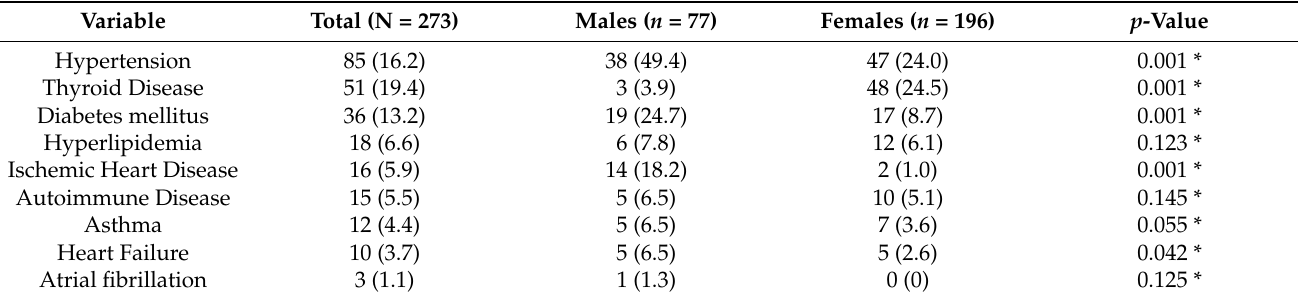
Table 2. Percentage of comorbidities (%) in Malesina’s population (N =